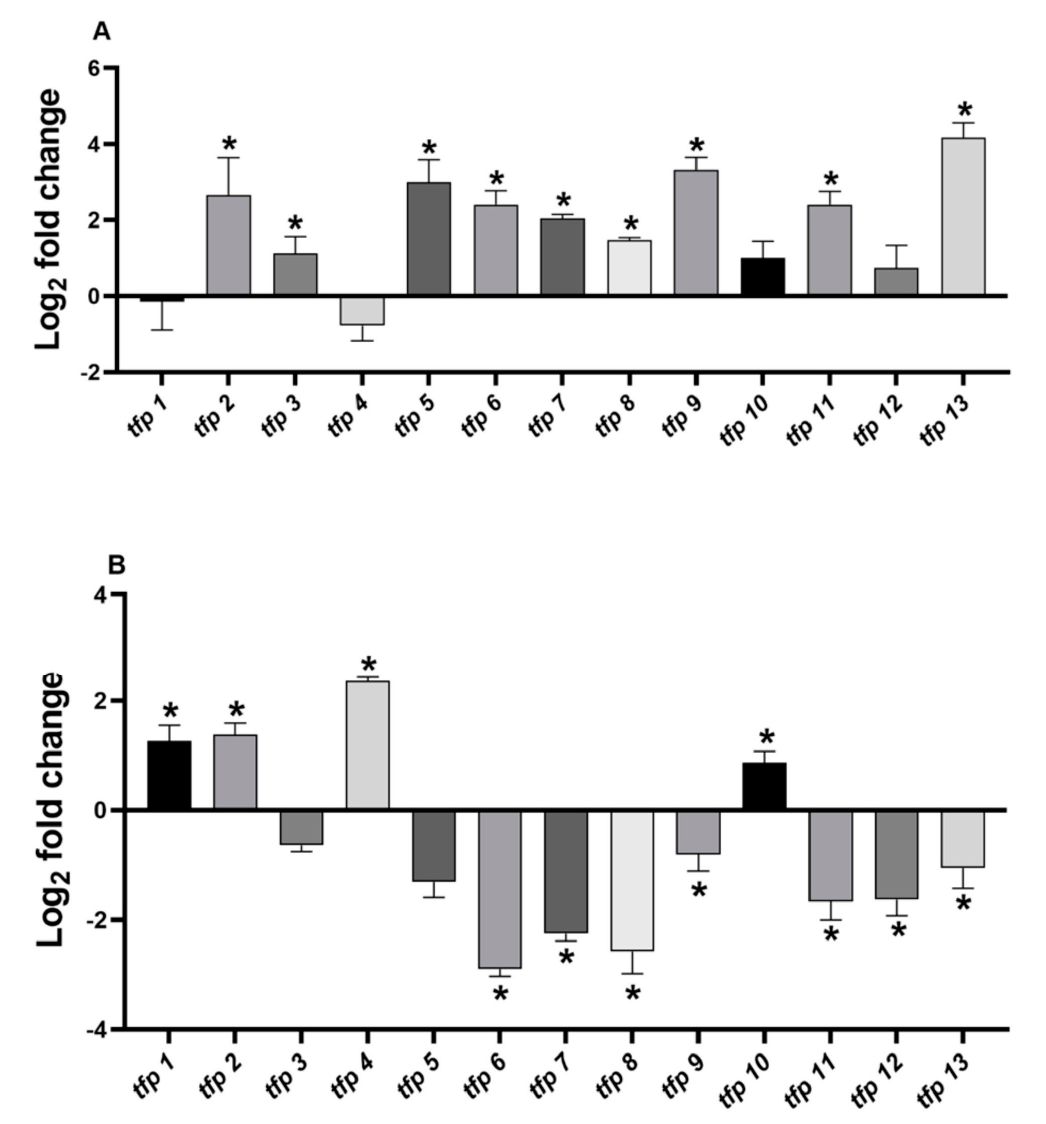
Figure 2. Relative expression of tfp genes from Leptospirillum sp. CF-1. Cells were stressed with (Fe 2 (SO 4 ) 3 ) ( A ) or diamide ( B ) for 1 h as indicated in Material and Methods. The RNA samples were analyzed in triplicate and ∆ Ct results compared to the control 16S RNA gene. Bars represent the average of three independent experiments ± standard deviation. (*): p < 0.05.